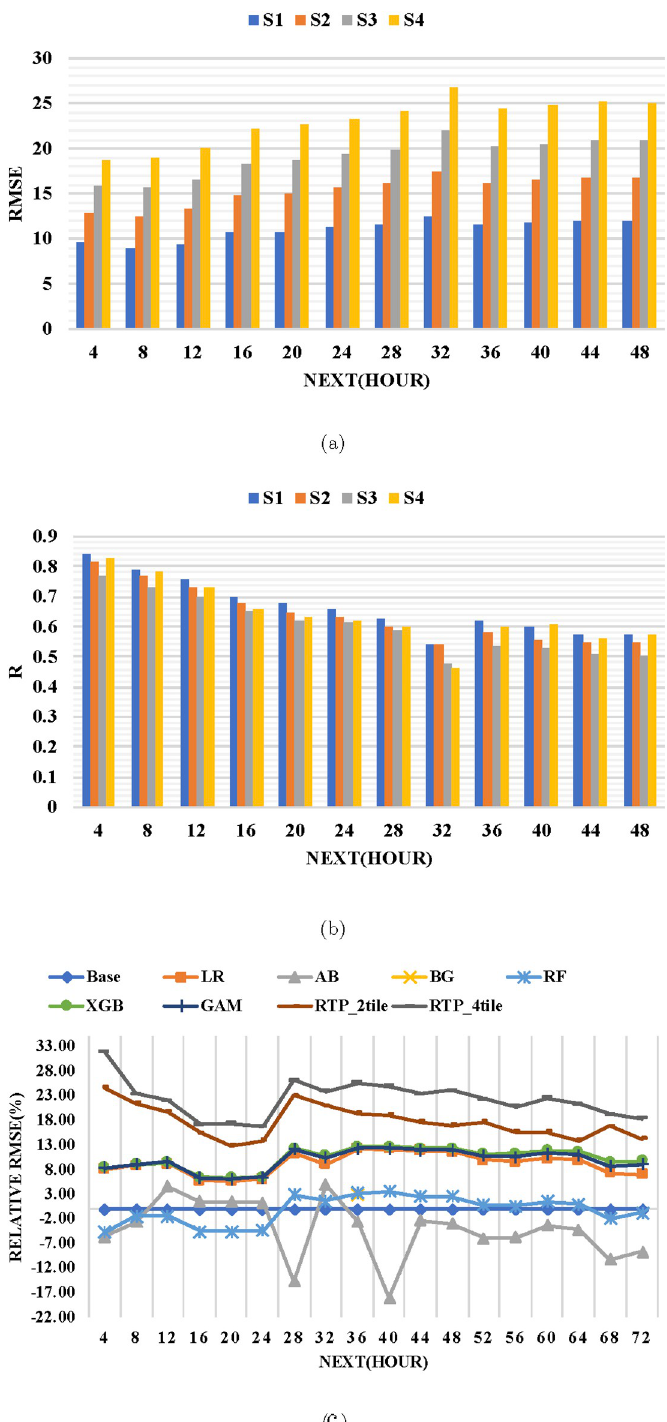
Fig 8. RTP model performance. The RTP performance in (a)RMSE and (b)R on four seasons in year. (c):Relative RMSE Improvement (%) of all models with reference to base model.